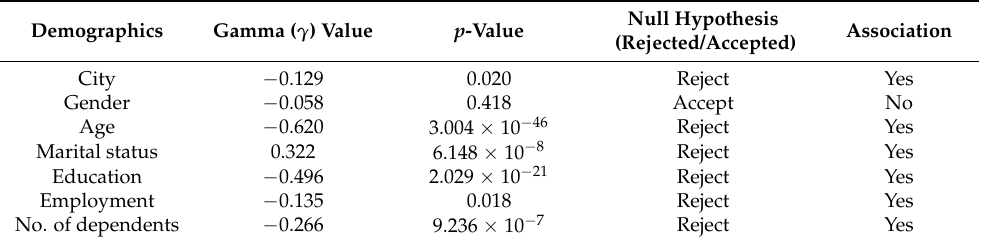
Table 2. Goodman and Kruskal’s gamma correlation between demographic factors and